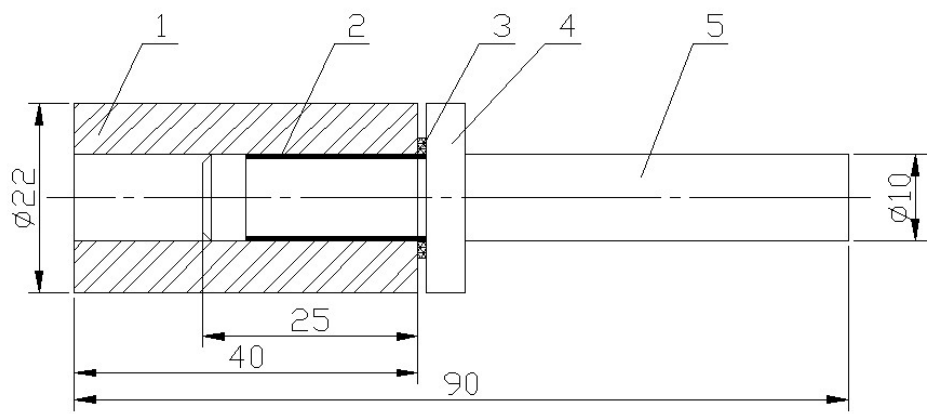
Figure 1. Schematic diagram of wrapping up the solder foil for sintering.